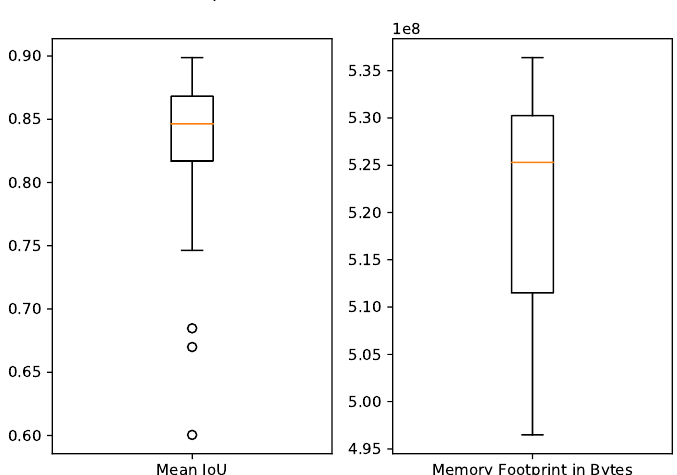
Figure 13. Boxplot results for the São Carlos Rivers dataset using the ResNet101 backbone and 512 MB of desired memory footprint.